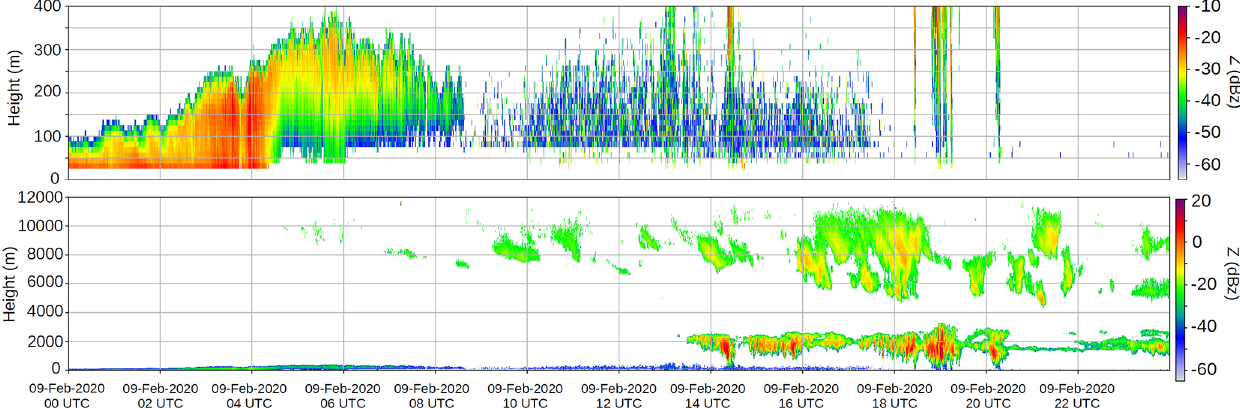
Figure 1. Reflectivity profiles at 95GHz (dBZ) measured by the BASTA cloud radar in the first 500m (top) and up to 12000m altitude (bottom), with UTC times given on the x axis, for the day of 9 February 2020 at Saint-Symphorien (Les Landes region). From http://basta. projet.latmos.ipsl.fr/?bi=bif (last access: 31 March